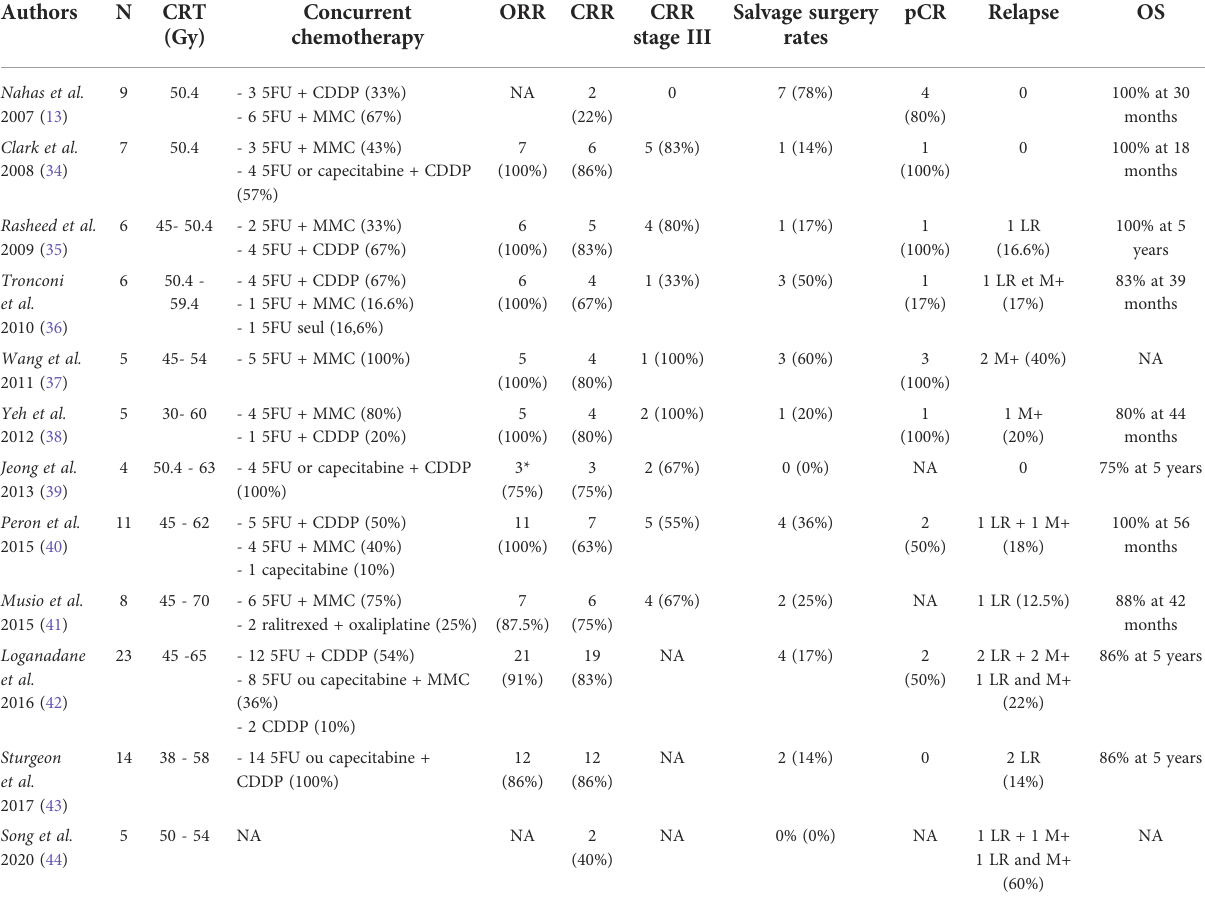
TABLE 3 Review of literature, patients with rectal squamous cell carcinoma treated with chemoradiotherapy and salvage surgery. Authors N CRT Concurrent (Gy) chemotherapy